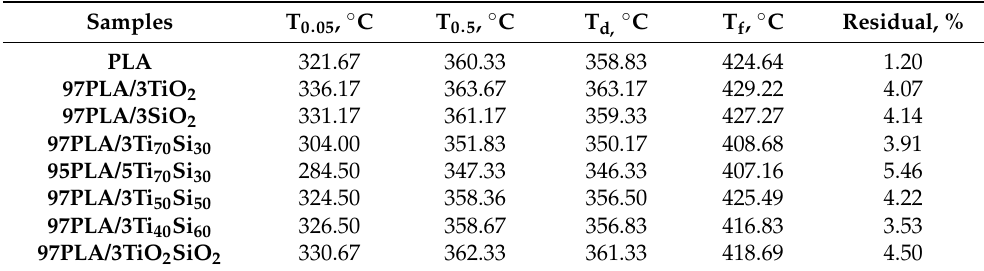
Table 3. Thermal degradation temperature of PLA, PLA/TiO 2 , PLA/SiO 2 , PLA/Ti x Si y , and PLA/TiO 2 SiO 2